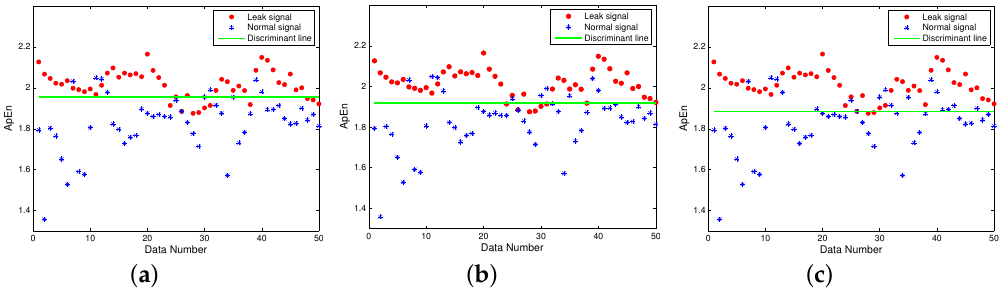
Figure 7. ApEn of signals for different threshold values. ( a ) r = 0.3 SD . ( b ) r = 0.2 SD . ( c ) r = 0.1 SD